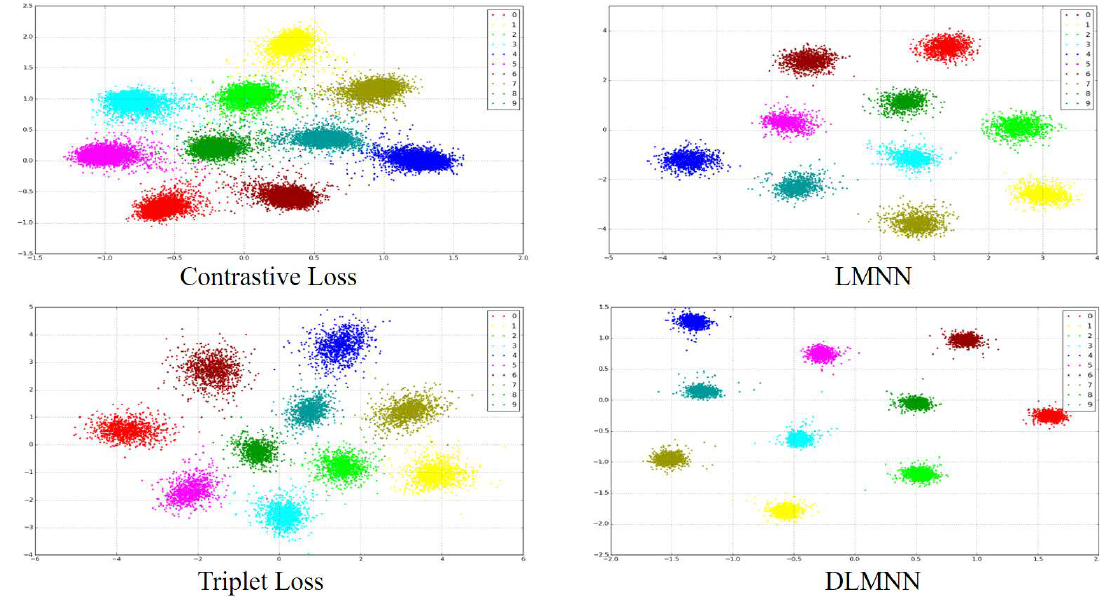
Figure 4: The distribution of learned features in MNIST training set by different methods.